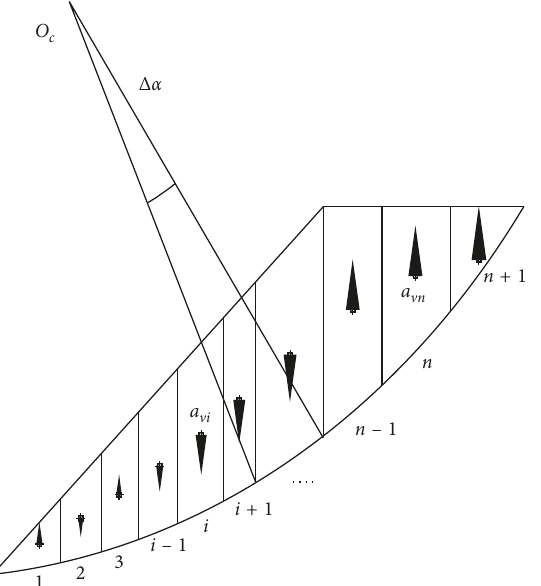
Figure 2: Diagram of forces acting on a soil